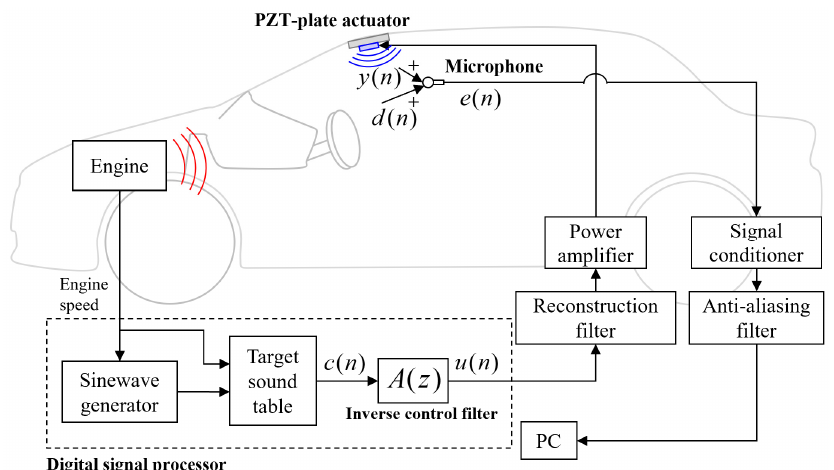
Figure 2. Block diagram of the proposed ASE system using a PZT actuator bonded on a plate at the mounting location of the rear mirror of a car.